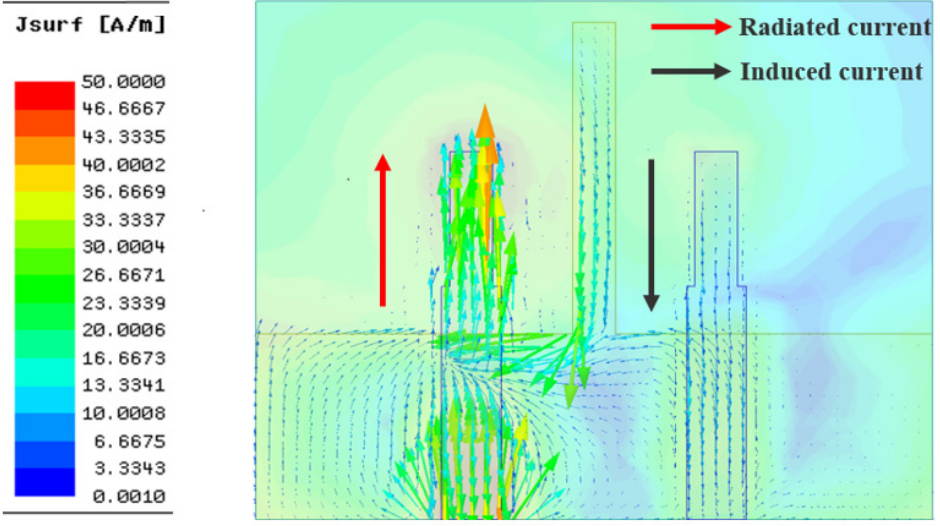
Figure 7. The distribution of surface current vectors of antenna 2.